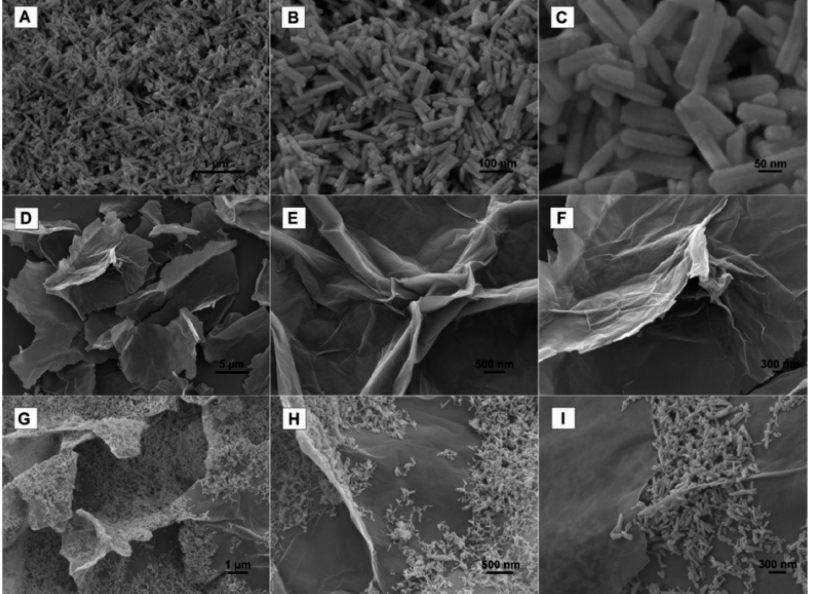
Figure 3. FE-SEM micrographs of the GdO nanorods ( A – C ), graphene aerogel ( D – F ) and nanocom- posite consisting of GdO nanorods and graphene aerogel ( G – I ). Reprinted with permission from Ref. [86]. Copyright 2020 American Chemical Society.